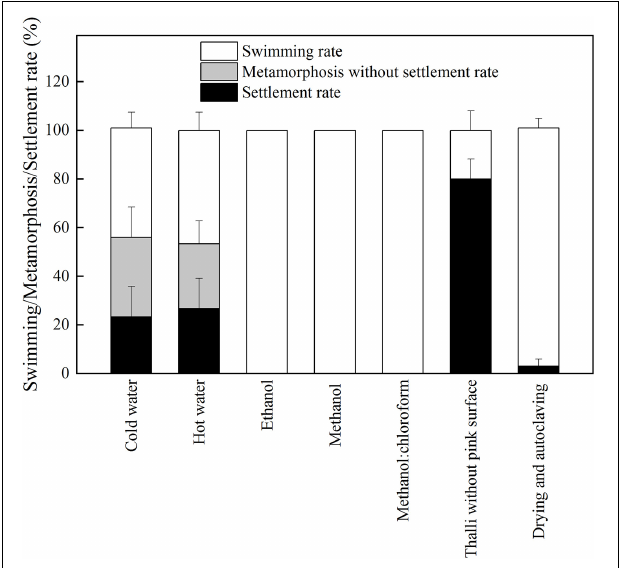
FIGURE 2 | The responses of larval settlement and metamorphosis to the treated P. onkodes and algal extracts at 24 h.